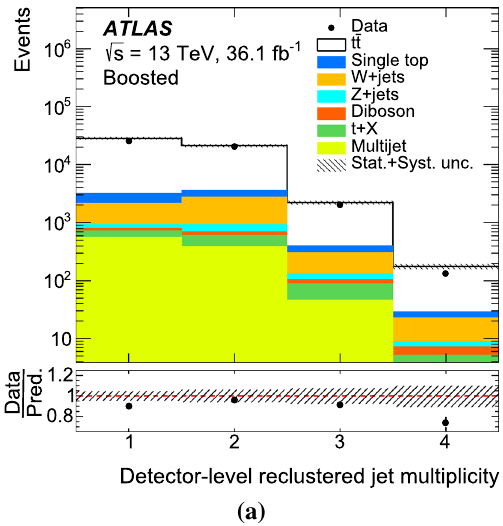
in Sect. 9) in the total prediction, excluding systematic uncertainties relatedtothemodellingofthe t ¯ t events.Underflowandoverflowevents, if any, are included in the first and last bins. The lower panel shows the ratio of the data to the total